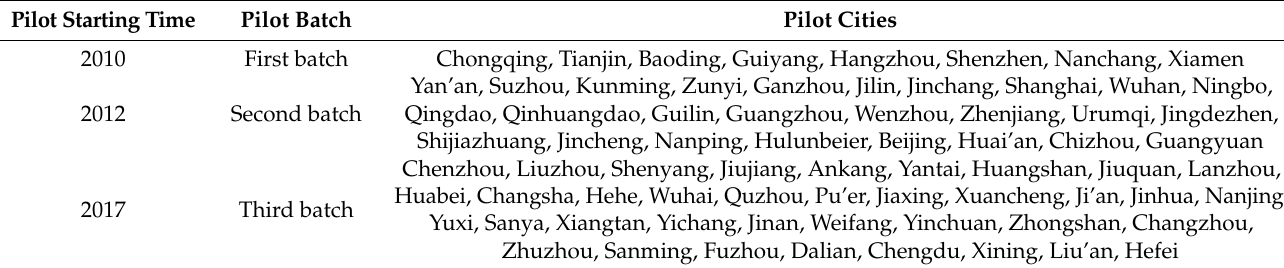
Table 1. Low-carbon city pilot policy